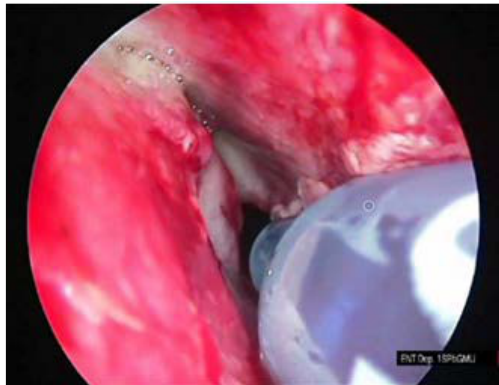
Figure 2. Filling of the sphenoid sinus with 0.01% methylene blue solution with the insulin syringe.